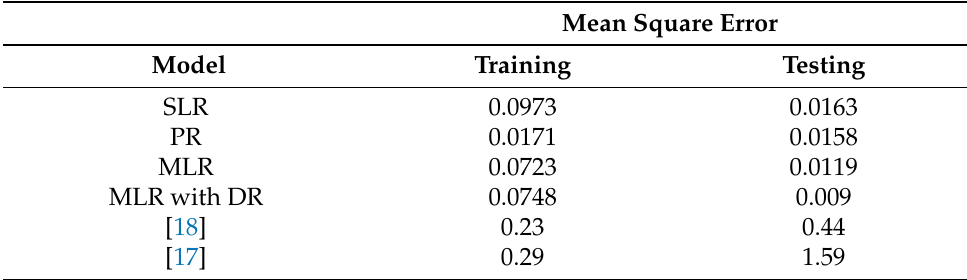
Table 13. Performance comparison with existing complex